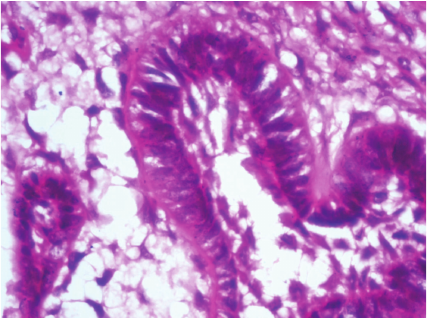
Figure6:Photomicrographshowingtallcolumnarameloblastswith reversal of